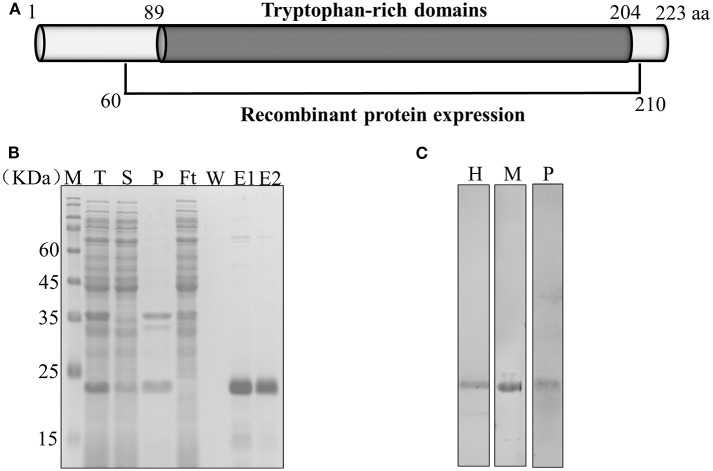
Schematic diagram showing the expression of PvTRAg-26. (A) Diagram of the gene structure of pvtrag-26; aa, amino acids. (B) Expression and purification of recombinant PvTRAg-26. T: total translation mix, S: supernatant, P: precipitate, Ft: flow through, W: wash; E: elution treated with reducing buffer. (C) Recombinant PvTRAg-26 protein under reducing conditions was probed with an anti-His tag antibody, P. vivax malaria patient serum and immune mouse serum. H: anti-His tag antibody, M: immune mouse serum, P: P. vivax-infected patients' pooled sera.